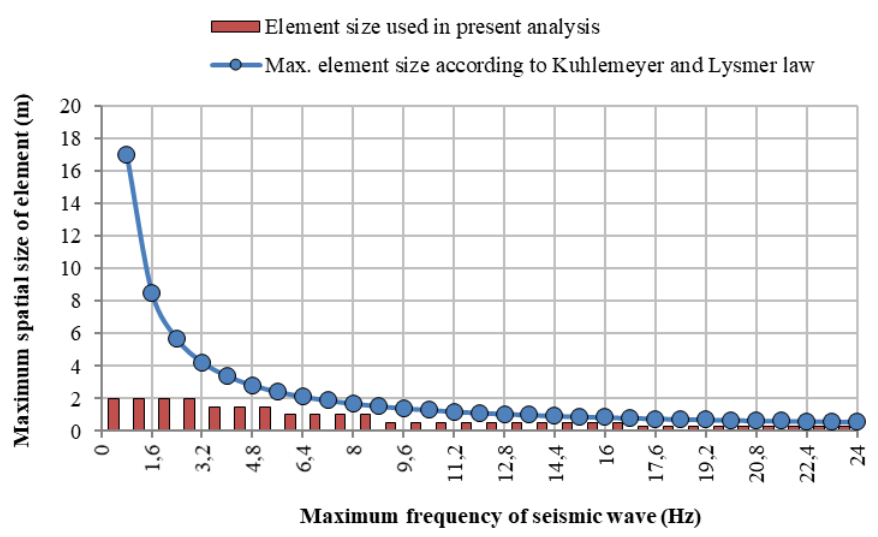
Figure 5: Maximum element size in the dynamic model according to Kuhlemeyer and Lysmer law (blue line) and element size used for the purposes of this analysis (red bars).